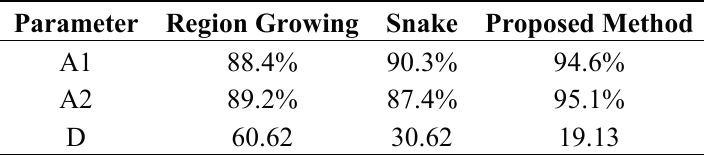
Table 1. Performance